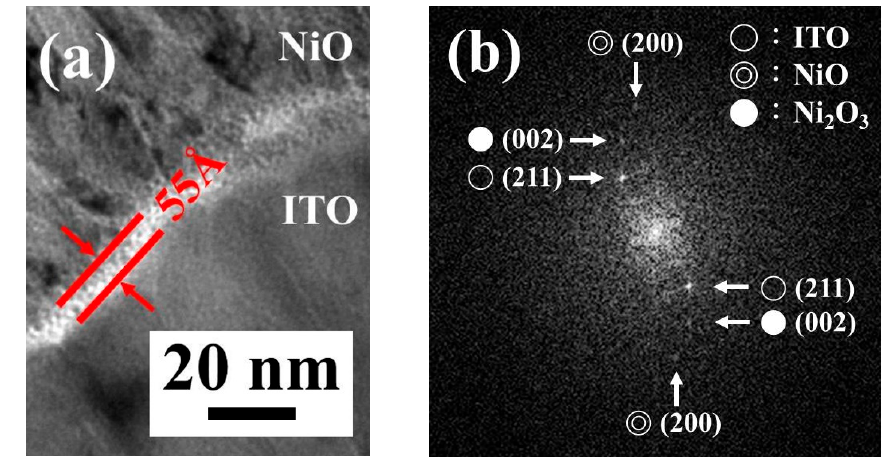
Figure 12. ( a ) TEM image and ( b ) SAED pattern of the L2NiO/ITO transparent heterojunction